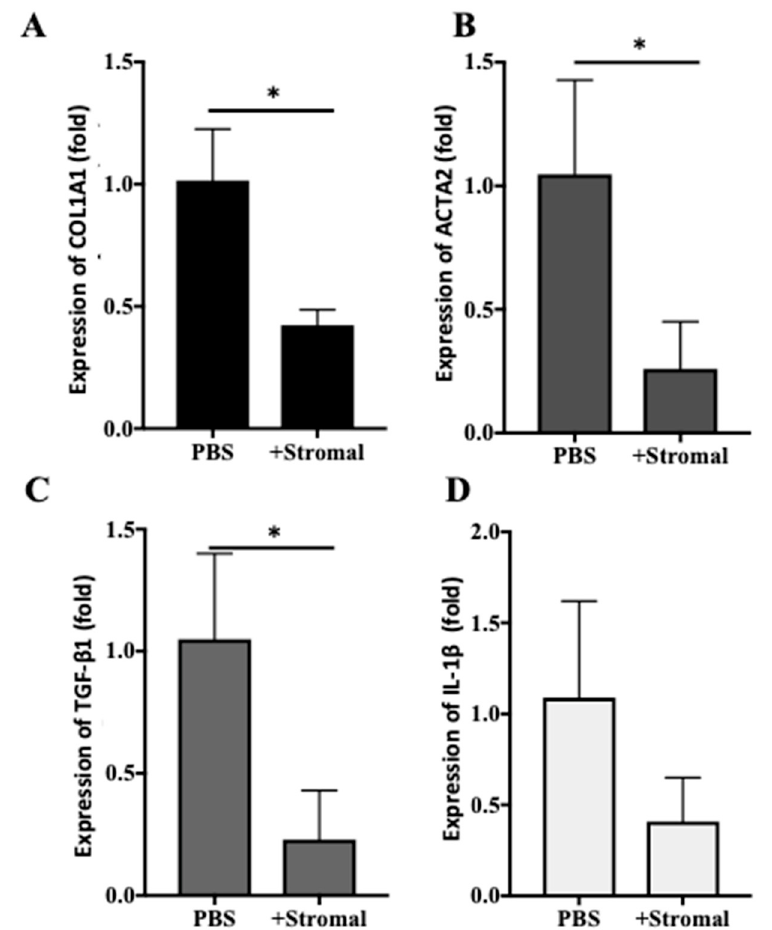
Figure 7. Effect of stromal cell exosomes on the expression of fibrotic markers in LX-2 cells. Non-activated LX-2 cells were cultured in the presence (+Stromal) or absence (PBS) of exosomes isolated from stromal cells for 2 days. Total RNA was isolated from LX-2 cells, and the relative expression of COL1A1 ( A ), ACTA2 ( B ), TGF β 1 ( C ), or IL-1 β ( D ) was quantified by qPCR. The relative expression of each gene in the presence of exosomes was normalized to that of control (PBS), which was set as 1. Data are presented as mean ± SD ( n = 3). * p < 0.05.